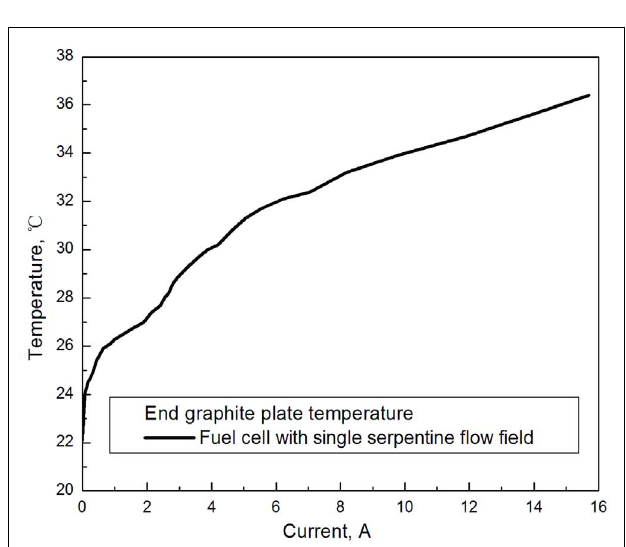
FIGURE 12 | End-plate temperature distribution (under hydrogen flow supply of 500sccm) .